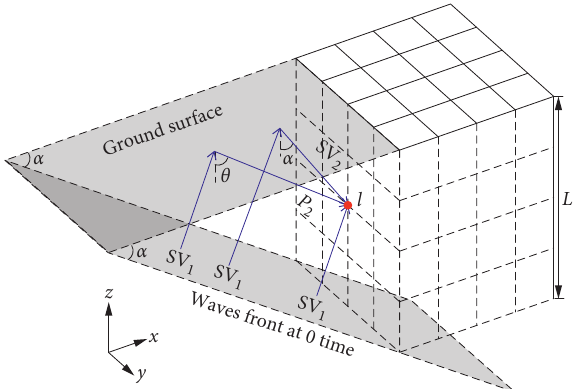
Figure 5: Oblique incidence of plane SV waves in three-dimen- sional